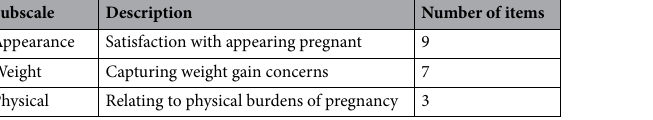
Table 4. Subscales of the